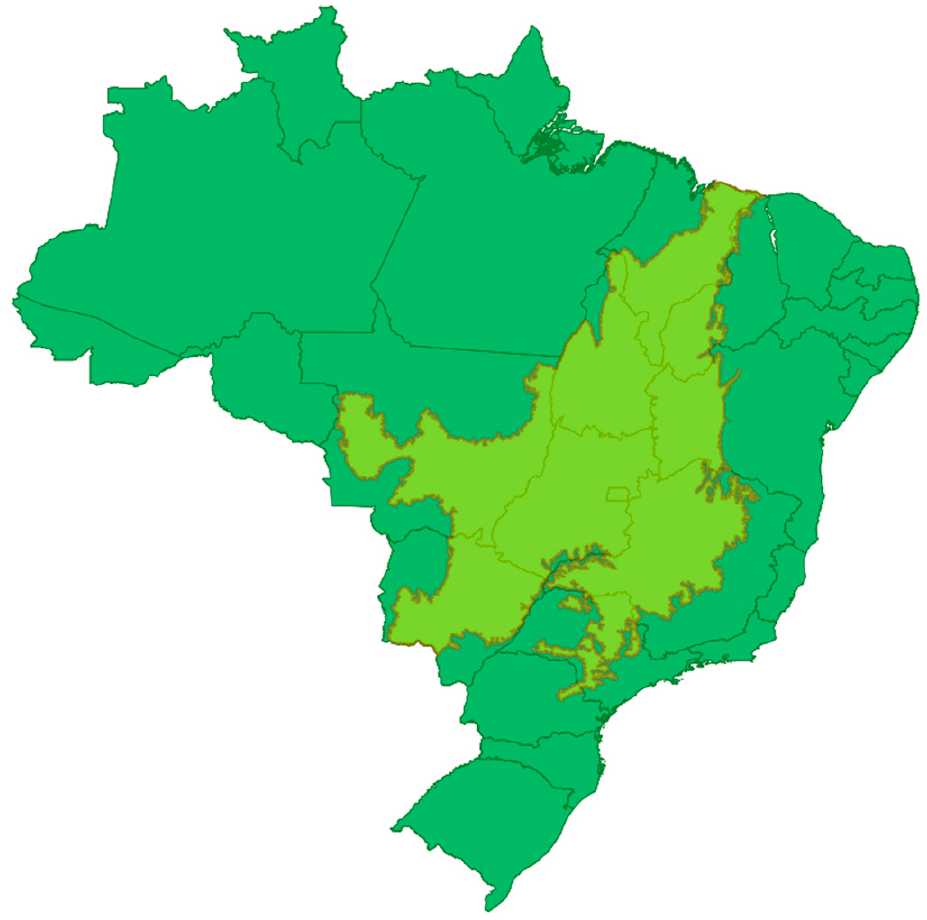
Figure 1. Cerrado delimitation area: light green area in Brazil map. Image from Laboratório de Farmacognosia/UnB adapted from templates available at Project MapBiomas (Project MapBiomas– Collection 5 of Brazilian Land Cover & Use Map Series, accessed on 26 February 2021 through the link: https://mapbiomas.org/mapas-de-referencia?cama_set_language=pt-BR).